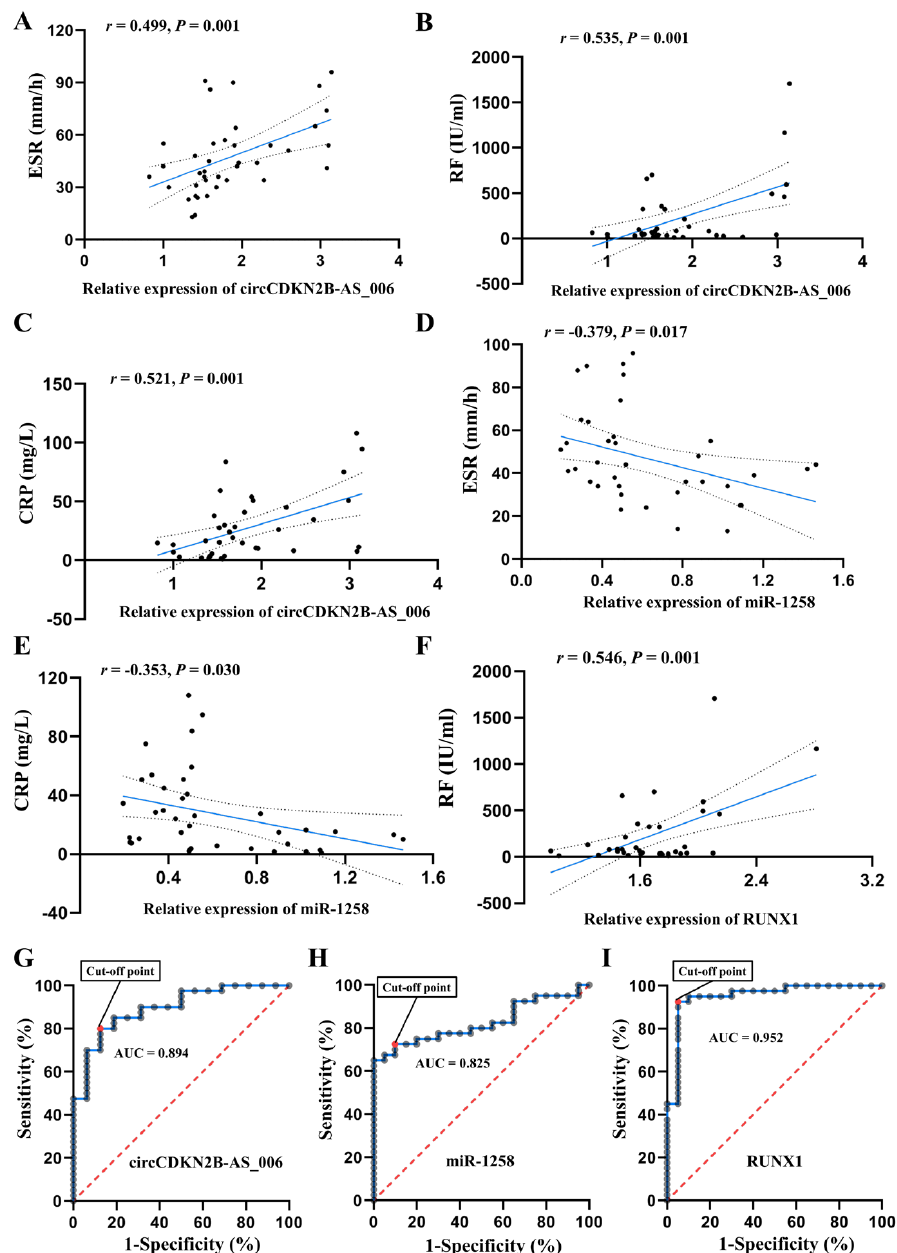
Figure 9. The circCDKN2B − AS_006/miR − 1258/RUNX1 axis is correlated with the clinical indicators of RA patients. ( A ) Correlation between circCDKN2B − AS_006 expression in synovia and ESR in patients with RA. ( B ) Correlation between circCDKN2B − AS_006 expression in synovia and serum RF levels in patients with RA. ( C ) Correlation between circCDKN2B − AS_006 expression in synovia and serum CRP levels in patients with RA. ( D ) Correlation between miR − 1258 expression in synovia and ESR in patients with RA. ( E ) Correlation between miR − 1258 expression in synovia and serum CRP levels in patients with RA. ( F ) Correlation between RUNX1 expression in synovia and serum RF levels in patients with RA. ( G ) ROC curve of circCDKN2B − AS_006 expression in synovia in discriminating patients with RA from patients with joint trauma. ( H ) ROC curve of miR − 1258 expression in synovia in discriminating patients with RA from patients with joint trauma. ( I ) ROC curve of RUNX1 expression in synovia in discriminating patients with RA from patients with joint trauma.